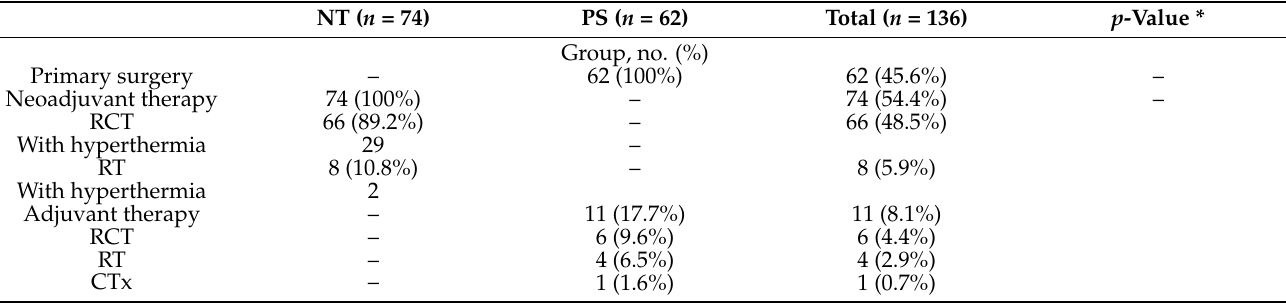
Table 2. Therapeutic and surgical characteristics ( n =